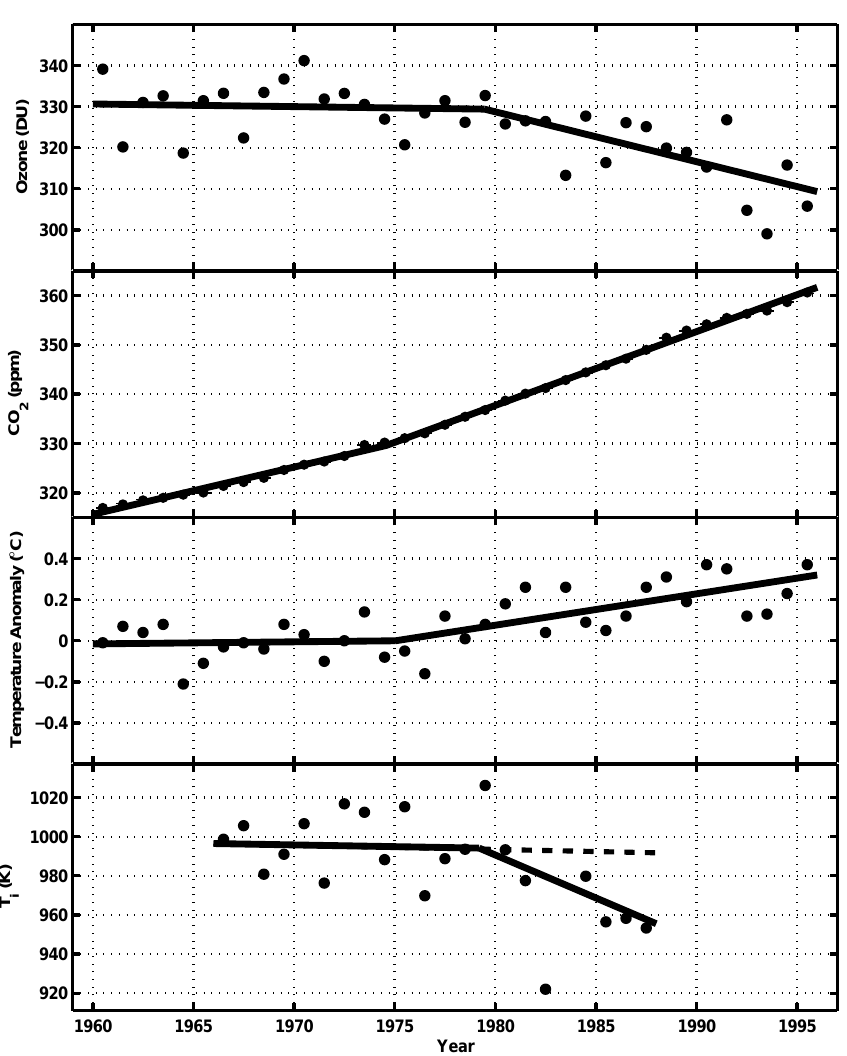
Fig. 1. Long-term trends in four atmospheric parameters. Top to bottom: (a) Annual average ozone column thickness over Arosa, Switzer- land. (b) Annual mean atmospheric carbon dioxide density at Mauna Loa Observatory. (c) Global land-ocean temperature change. (d) Ion temperature over Saint Santin, France at 200–400km altitude. The dashed line in the bottom panel is the model prediction of Roble and Dickinson